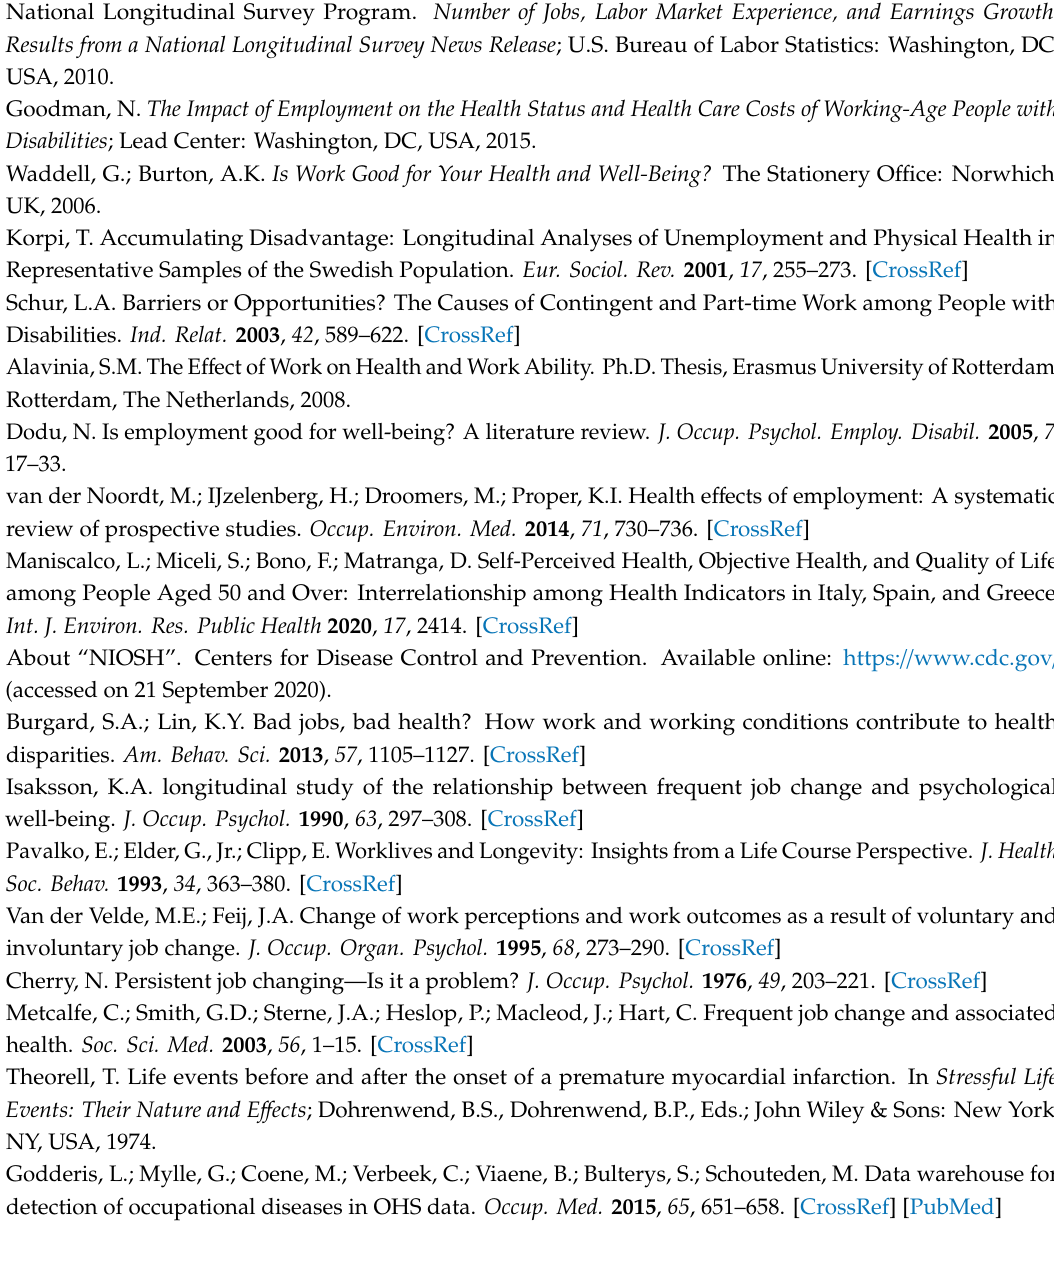
Table S1: List of risk